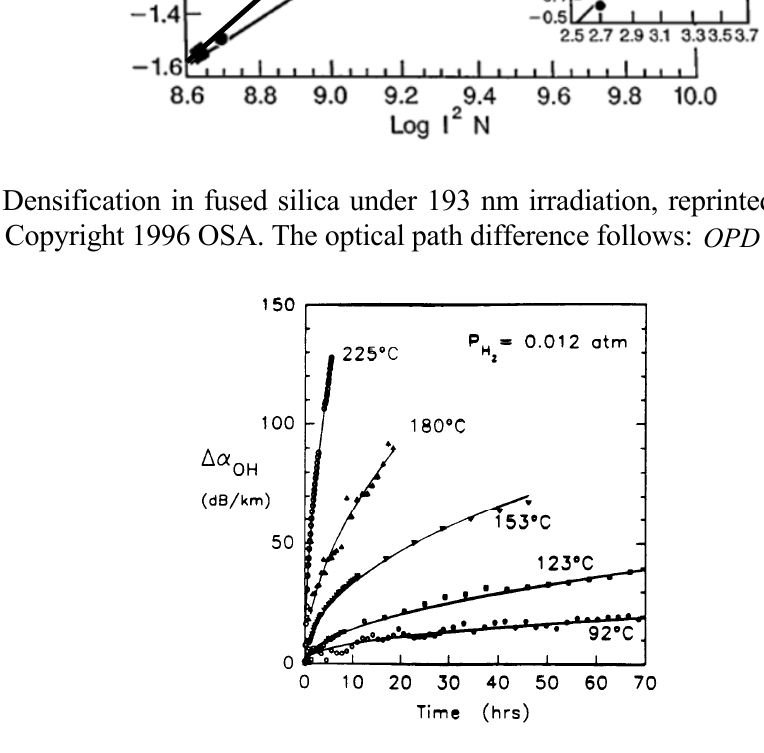
Figure 4. IR darkening of the Ge-doped core optical fiber, reprinted with permission from [12]. Copyright 1991 SPIE. The OH growth data are well described by an equation of the form: